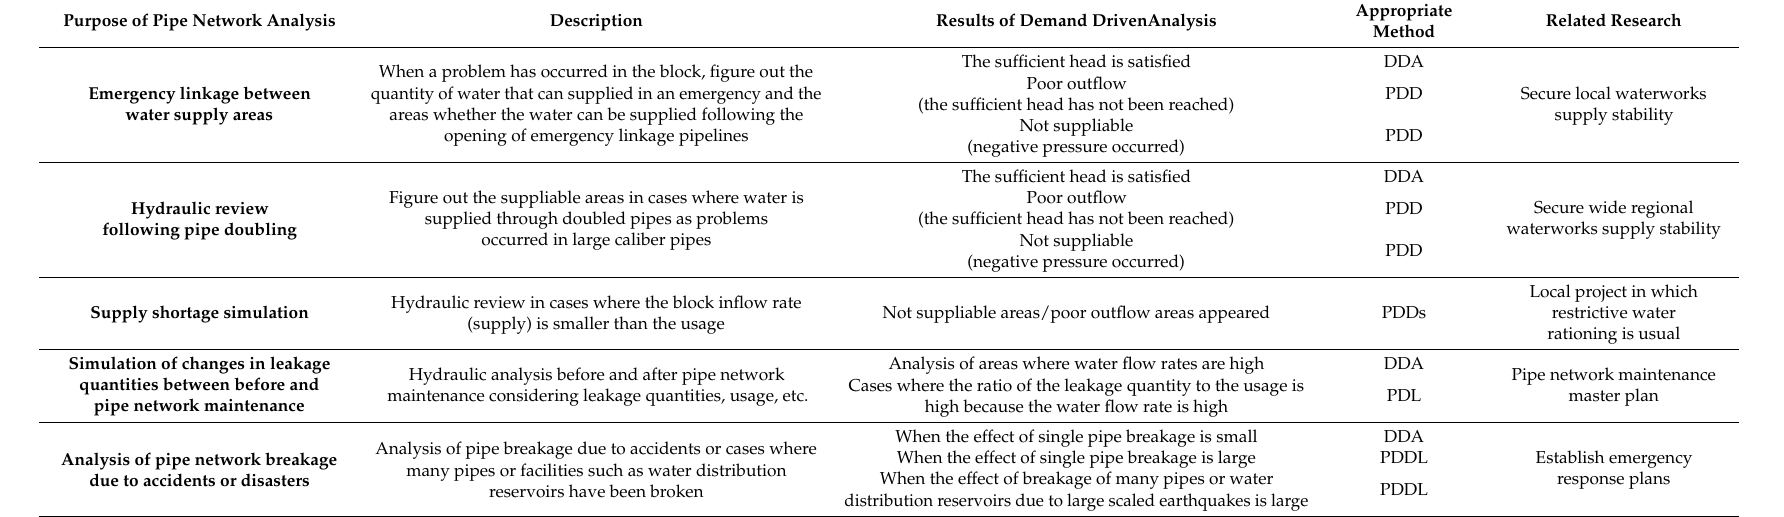
Table 2. Appropriate analysis techniques according to the purposes of pipe network